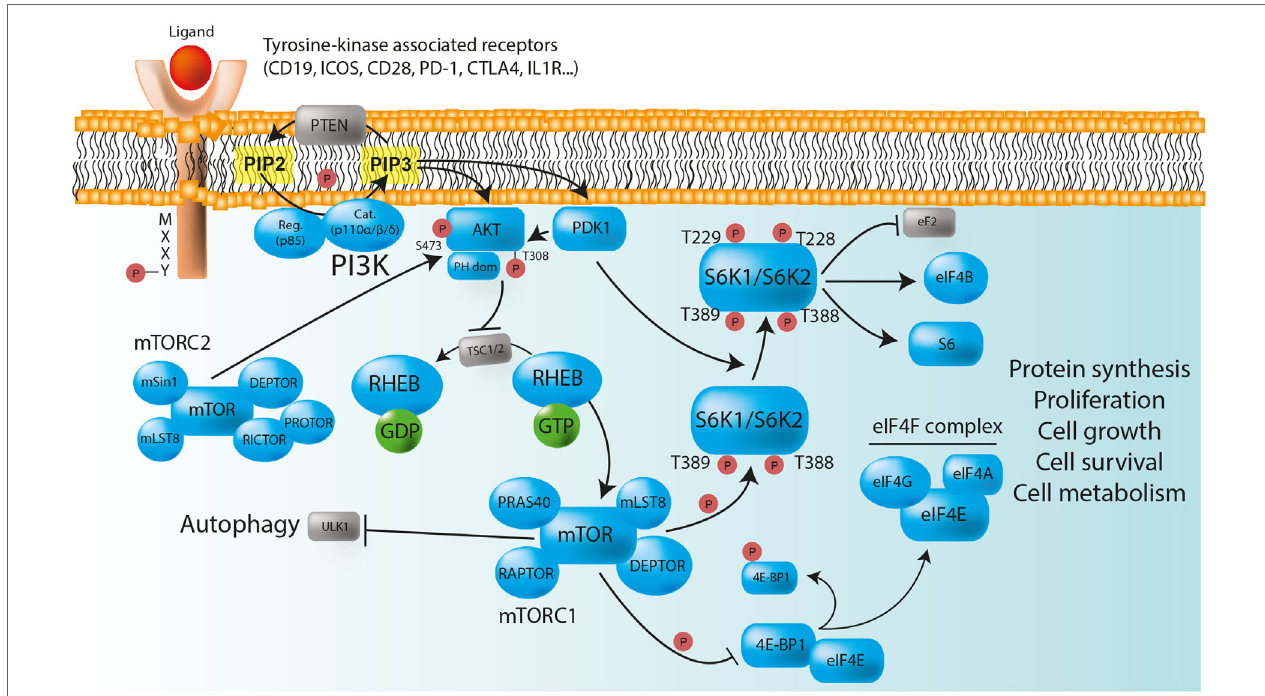
FiGURe 1 | The PI3K/AKT/mTOR/S6K pathway plays a major role in the control of immune cell homeostasis. Class IA PI3Ks are heterodimeric molecules composed of a p110 catalytic subunit (p110 α , p110 β , or p110 δ ) and a p85 regulatory subunit. In immune cells, class IA PI3Ks can be activated via multiple surface tyrosine kinase-associated receptors [e.g., BCR, TCR, TLR, CD19, ICOS, PD-1, and CTLA-4] that bear YXXM motifs in their cytoplasmic domain. In the absence of ligand binding, the TSC1/TSC2 complex negatively regulates mTORC1, and therefore protein synthesis, by converting RHEB into its inactive GDP-bound state. After receptor activation, phosphorylated YXXM motifs provide binding sites for the p85 regulatory subunit that brings the p110 catalytic subunit to the membrane, where it converts PIP 2 to PIP 3 . PIP 3 serves as plasma membrane docking sites for PH-domain containing proteins, such as AKT, and its upstream activator PDK1. The activity of AKT is also positively regulated by mTORC2. Once phosphorylated, AKT inhibits the TSC1/TSC2 complex, and allows the release of GTP-bound RHEB, thereby enabling mTORC1 activation. Activated mTORC1 triggers biosynthetic pathways (protein synthesis) essential for cell proliferation, survival, and metabolism through S6Ks and 4E-BP1 phosphorylation, while inhibiting ULK1, and therefore autophagy. S6K phosphorylate numerous substrate, including ribosomal protein S6, eukaryotic translation initiation factor eIF4B, and eukaryotic elongation factor 2 (eEF2) kinase. The phosphorylation of 4E-BP1 prevents its binding to the cap-binding protein eIF4E, allowing it to participate in the formation of the eIF4F complex, which is composed of the DEAD-box RNA helicase eIF4A, the cap- binding protein eIF4E, and the large “scaffold” protein eIF4G, and which is required for the initiation of cap-dependent translation. PTEN is a negative regulator of PI3K/AKT/mTOR/S6K signaling pathway that dephosphorylates PIP 3 back to PIP 2 . Red circles: phosphorylation; normal arrows: activation; blunt arrows: